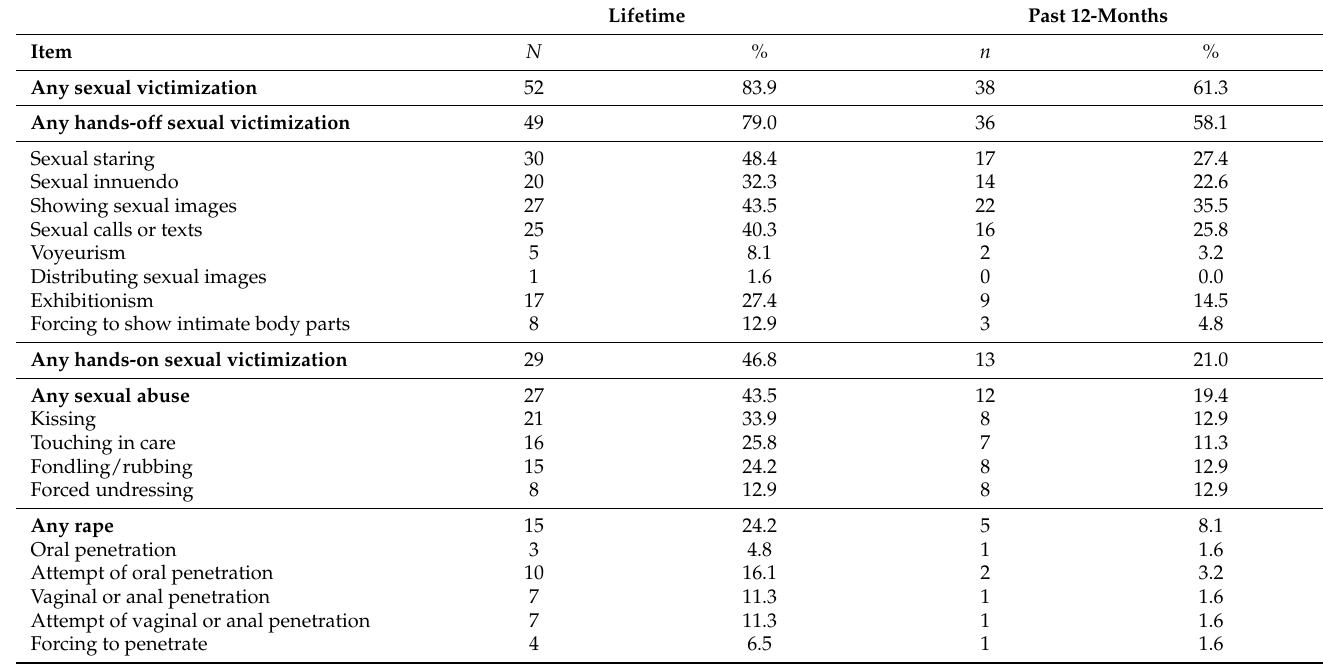
Table 2. Lifetime sexual victimization and sexual victimization in the past 12 months.